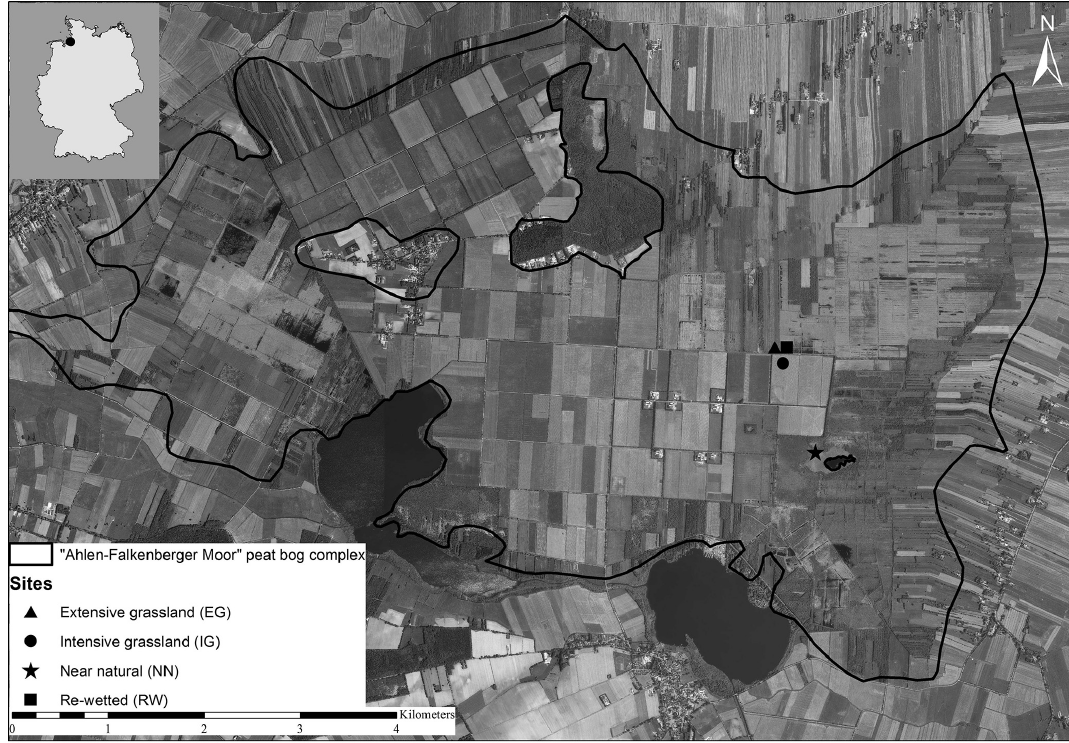
Fig. 1. Location of the study sites within the “Ahlen-Falkenberger Moor” peat bog complex and location of the “Ahlen-Falkenberger Moor” peat bog complex within Germany (upper left) (BKG,